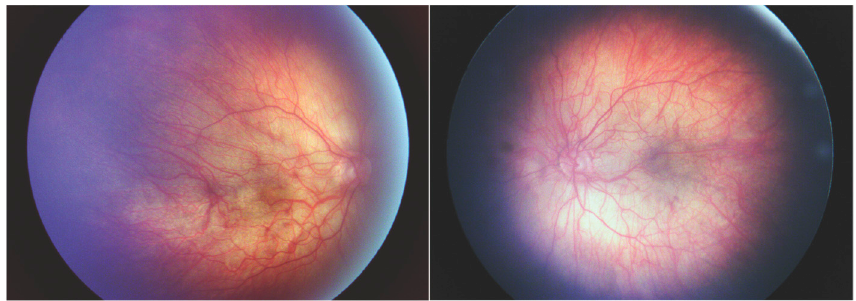
Figure 4. Fundus photos of Patient III-7. Fundus photos of Patient III-7 showing poor foveal reflex, mild vessel tortuosity, and peripheral pigmentation in the right (Figure 2A) and left (Figure 2B).